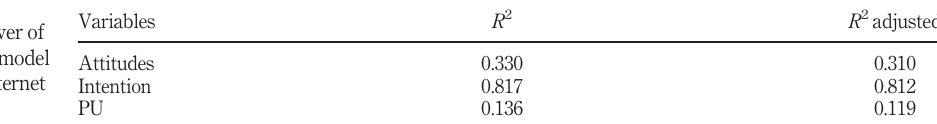
Figure 9. Diagram of the estimated model for non-users of internet banking